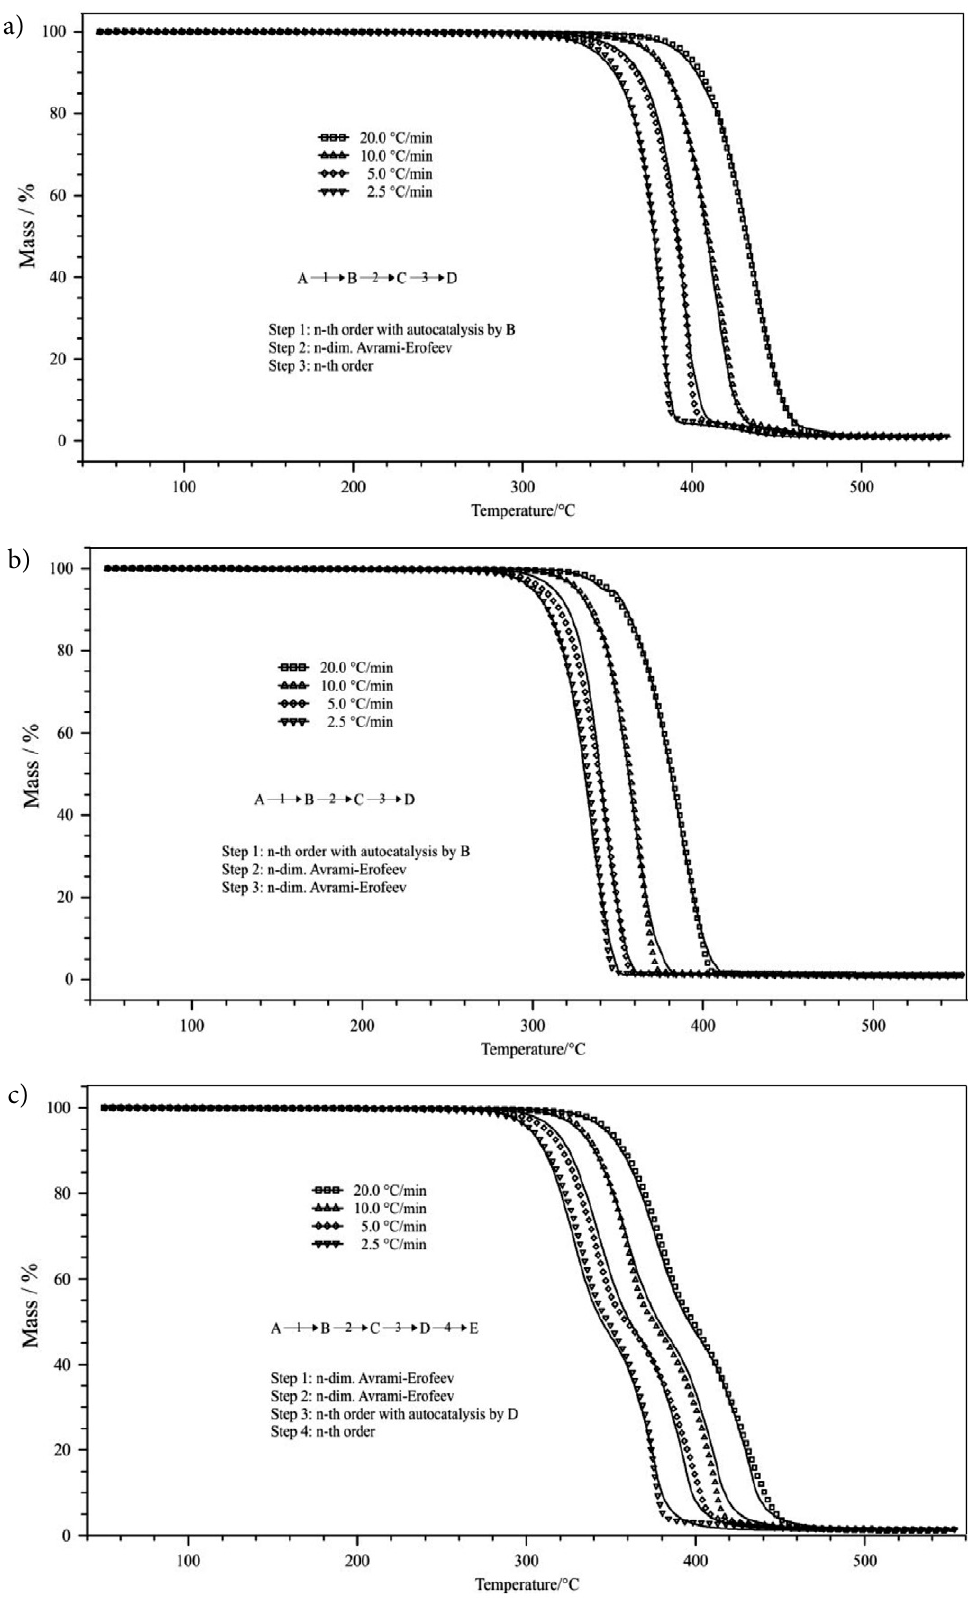
Fig. 5. Comparison of experimental data (points) and best fitted kinetic models (solid lines) calculated from multivariate nonlinear regression meth- od for the PCL (a), PLA (b) and PCL/PLA (50/50)